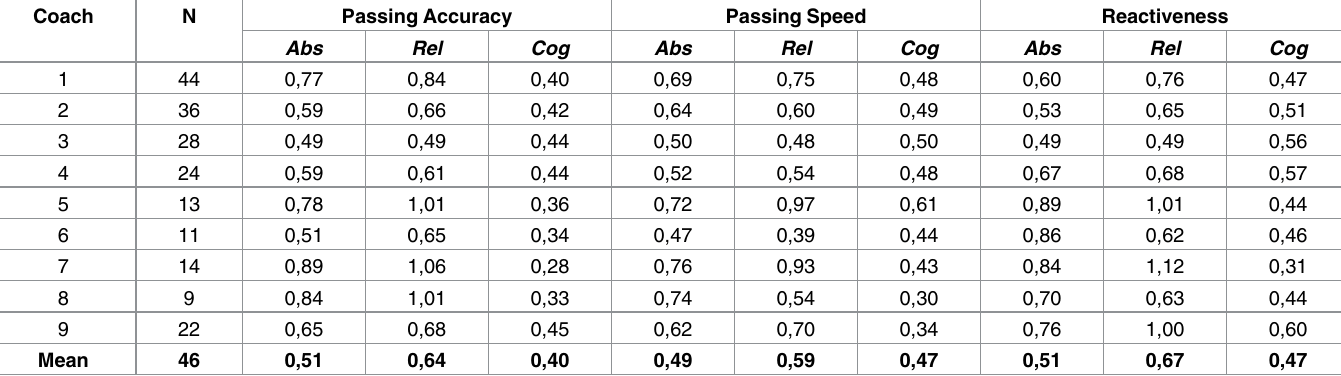
Abs, Rel and Cognifoot correspond to absolute / relative coaches’ judgments and COGNIFOOT scores, respectively. The last “virtual” coach (Mean Coach) scores were computed by averaging the scores of different coaches for a same player. Note that except for coach 3, COGNIFOOT’ RMSEs are systematically lower than coaches’ RMSEs, denoting a higher variability in coaches’ scores. Averaging coaches’ scores across players (Mean Coach) resulted in RMSE of similar magnitude between coaches and COGNIFOOT although the variability of COGNIFOOT scores is still systematically lower (see text for